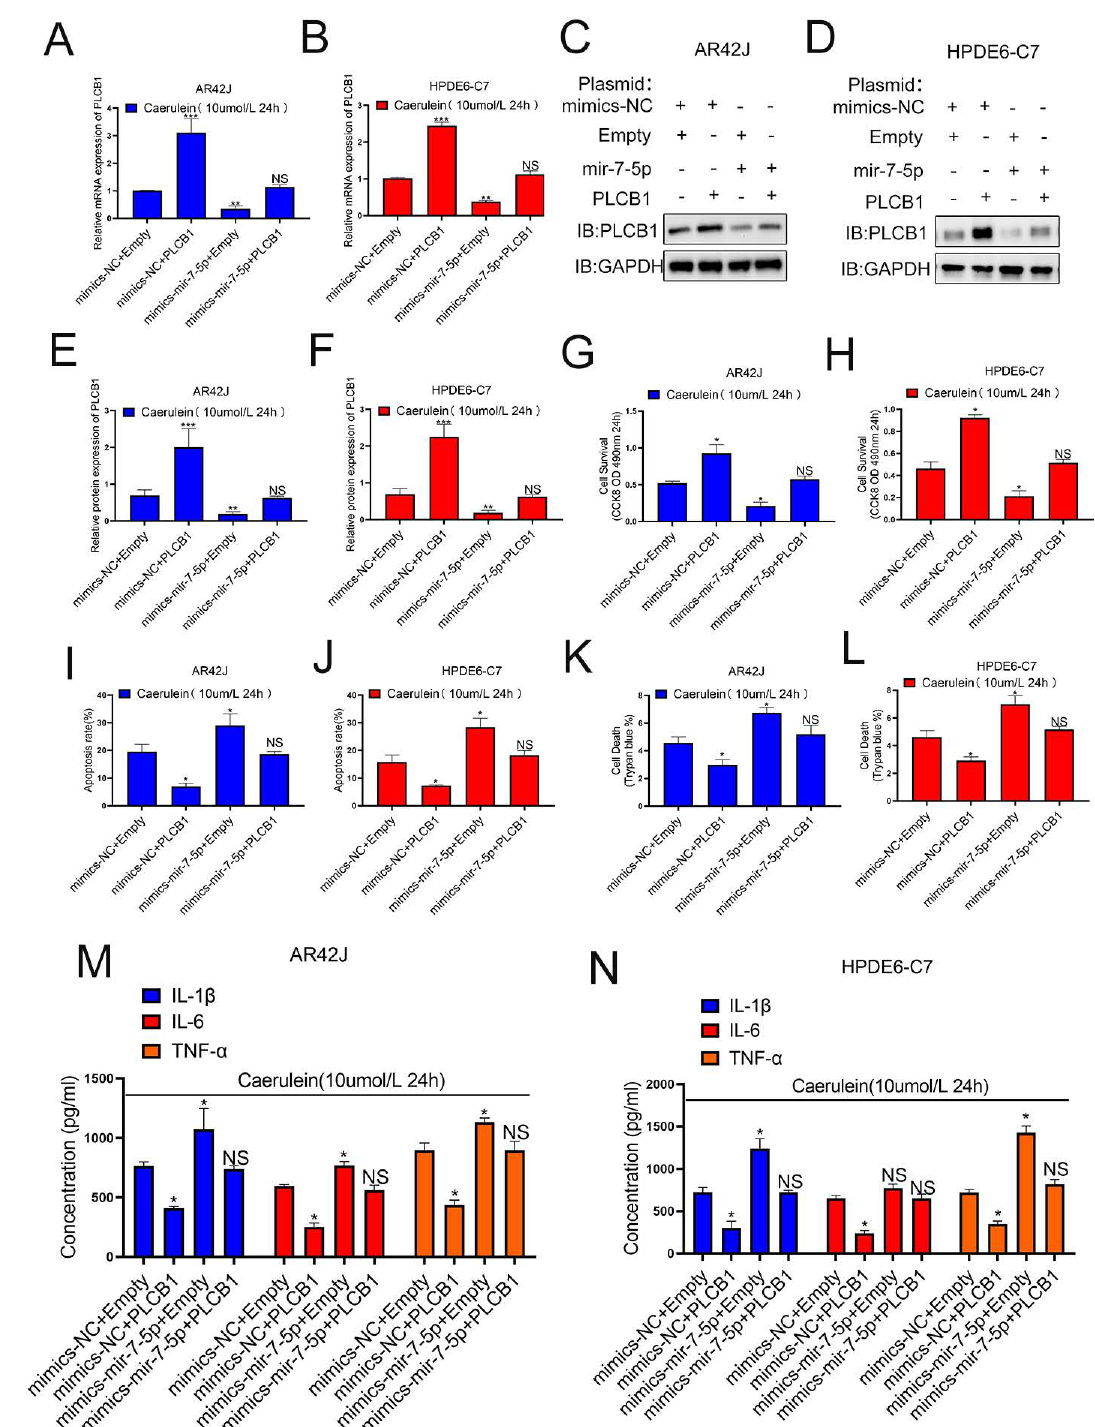
Figure 6. MiR-7-5p plays a promoting role through PLCB-1 in pancreatitis. ( A – F ) The expression of PLCB1 was verified in different cell models. ( G , H ) Cell proliferation was assessed by CCK8 assay in Figure 6A–F cell models. ( I , J ) Cell apoptosis was monitored by flow cytometry assay in Figure 6A–F cell models. ( K , L ) The effects of SNHG11 on cell death caused in Figure 6A–F cell models were observed by Trypan blue assay. ( M , N ) Expression of IL-6, TNF- α , and IL-1 β in Figure 6A–F cell models were assessed by ELISA. The data are presented as means ± SDs, n = 3 for each group, * p < 0.05; ** p < 0.01; *** p < 0.001, NS = no significance between the indicated